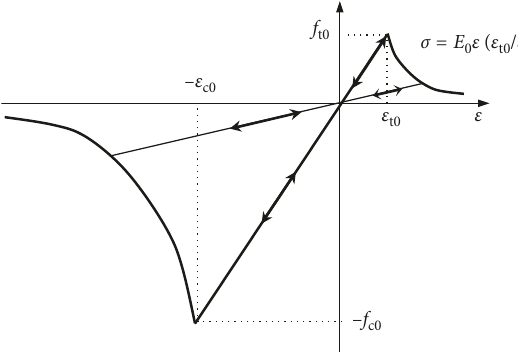
Figure 2: The elastic damage-based constitutive law under uniaxial stress